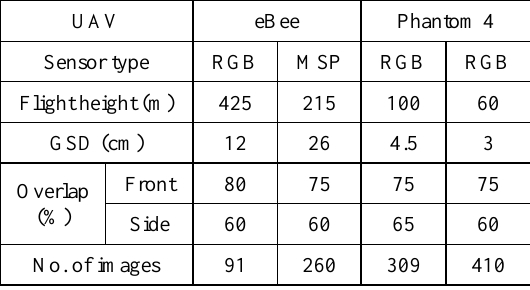
Table 1. Overall characteristics of the performed